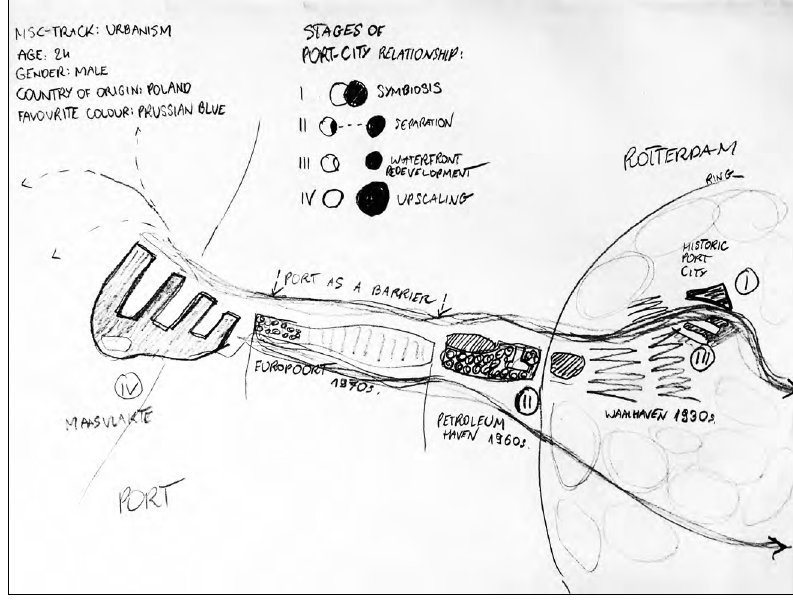
Illustrating an Acculturated Understanding of a Port-City in one Response, 2020, credits trough an anonymized response in the graduate course on People, Movement and Public Space by Maurice